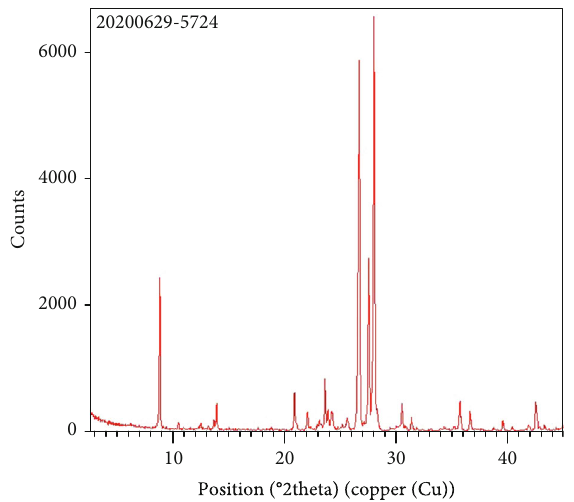
Figure 2: XRD di ff raction spectrum of